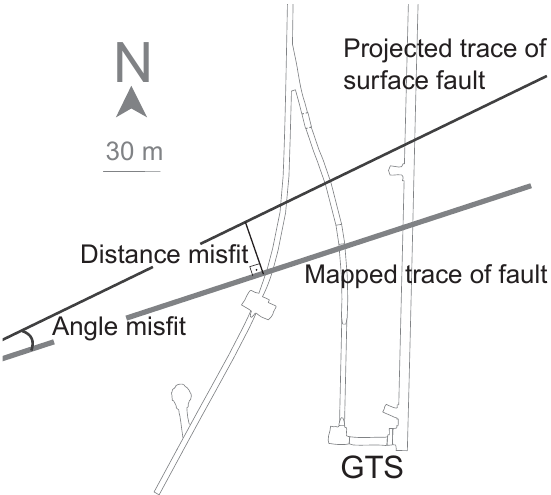
Figure 4. Schematic drawing of hypothetical example for validation of 3-D models based on angular and distance misfit (map view). The contours of the GTS are shown in grey with a mapped fault trace and a fault trace resulting from projection of the fault plane from the